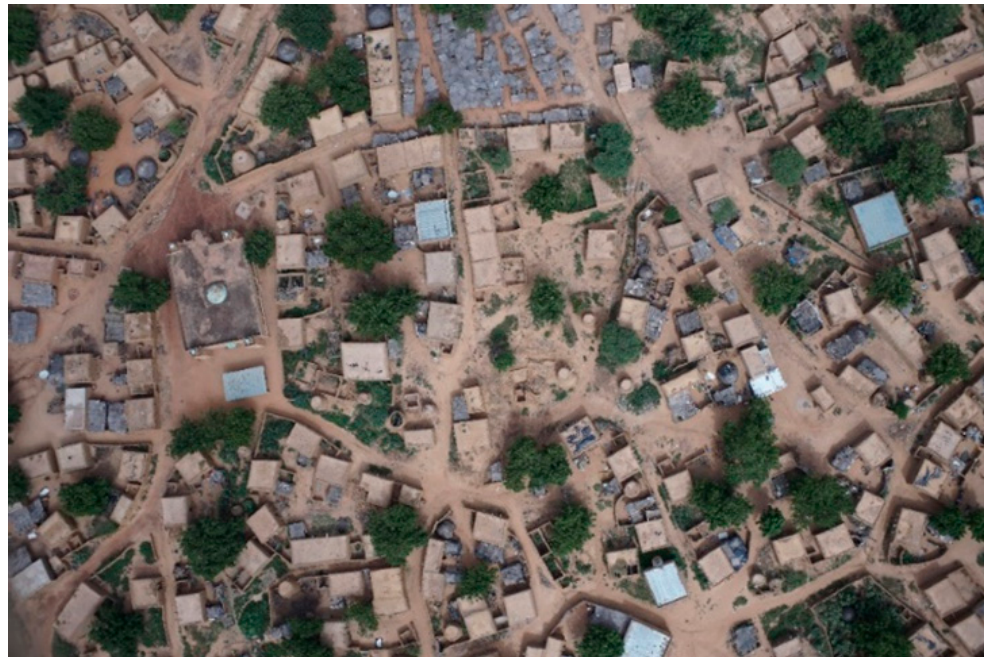
Figure 2. Example of local architecture. Nadiral view.